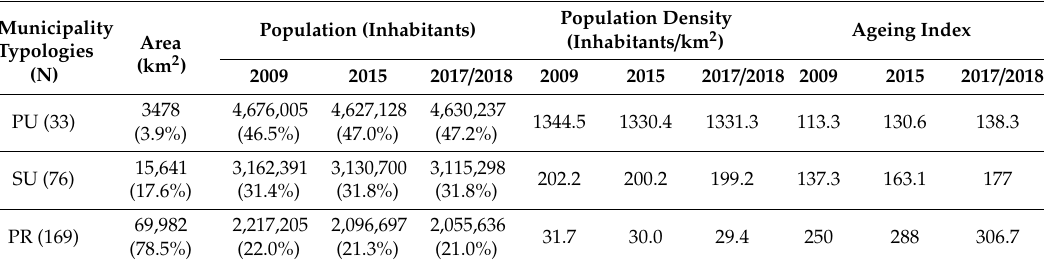
Table 3. Demographic characteristics of the three territory